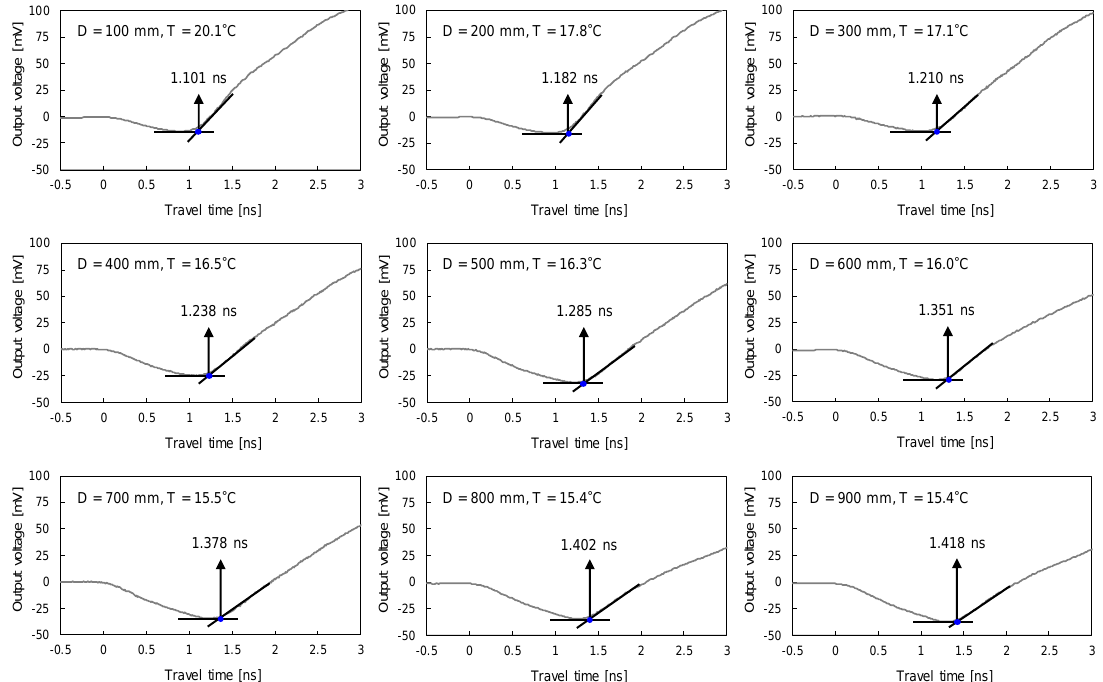
Figure 13. Measured TDCP signals and ground temperatures with depth.